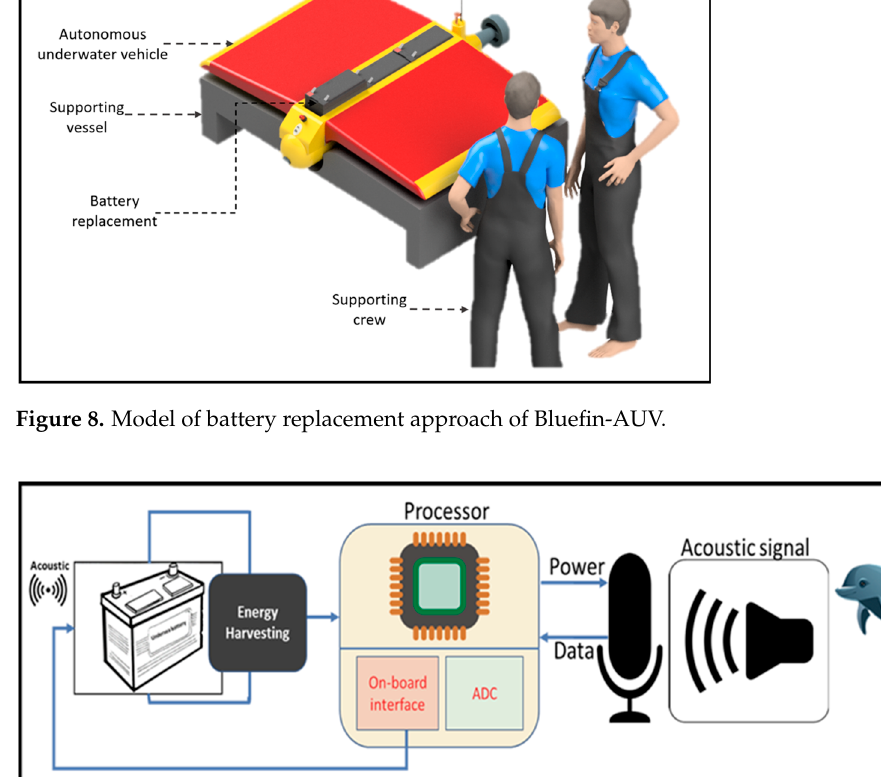
Figure 8. Model of battery replacement approach of Bluefin-AUV.